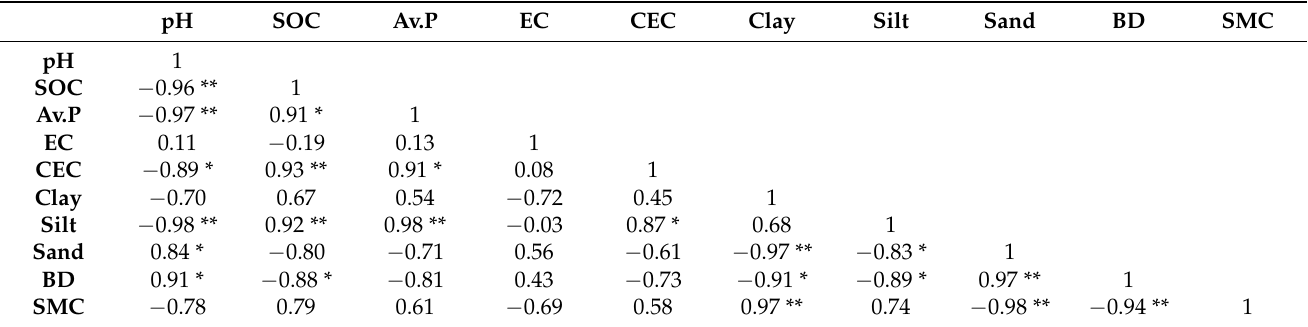
Table 3. Pearson correlations among the soil chemical and physical properties of the exclosure and open